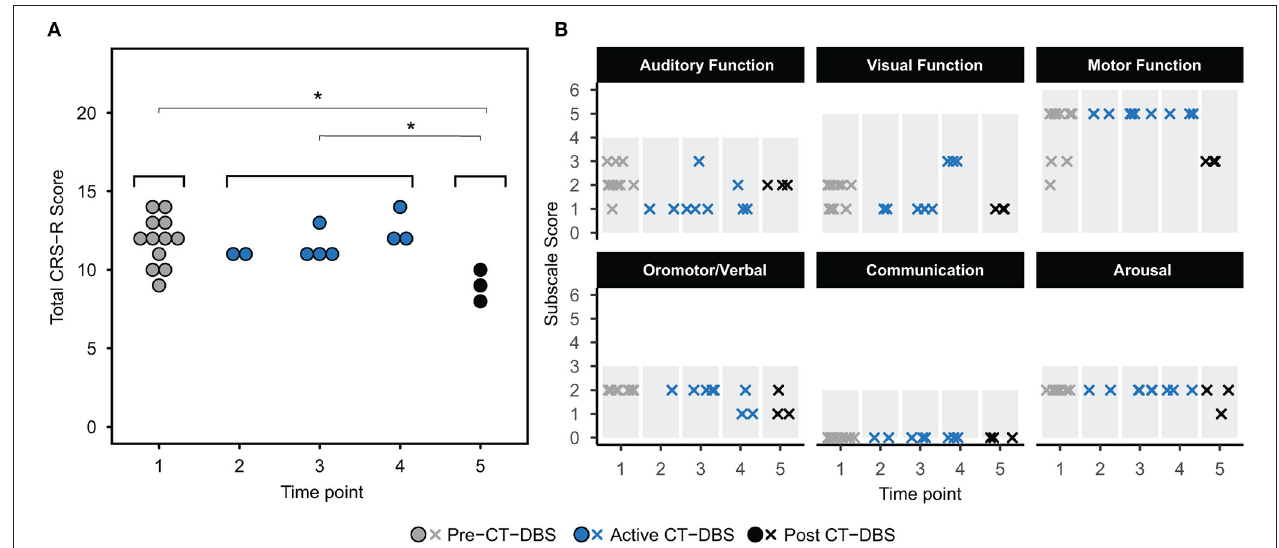
FIGURE 2 | Behavioral examination scores. (A) Coma Recovery Scale-Revised (CRS-R) total scores at each time point. Each data point represents a single CRS-R administration. * p < 0.05. (B) Corresponding CRS-R subscale scores display slight variations in composition of total CRS-R scores between time points. Each data point represents a single subscale administration. Gray rectangles indicate maximum subscale score range. Data points from pre-CT-DBS are shown in gray, active CT-DBS in blue, and post-CT-DBS in